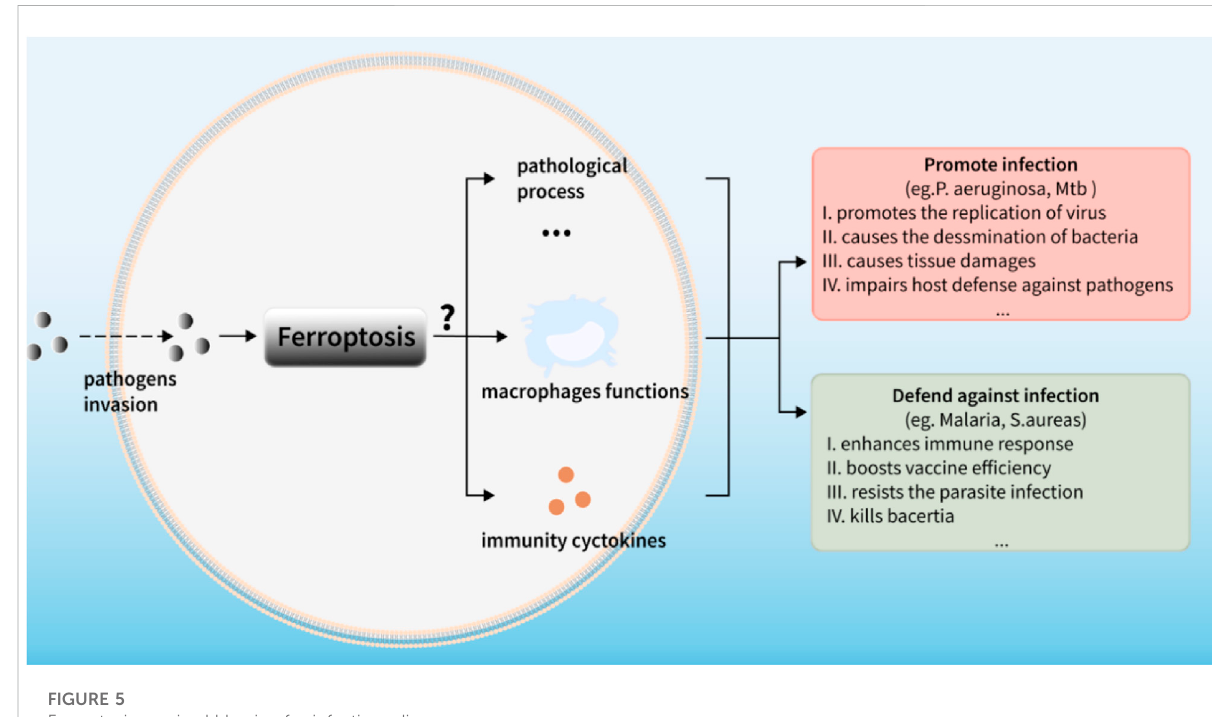
FIGURE 5 Ferroptosis: a mixed blessing for infectious